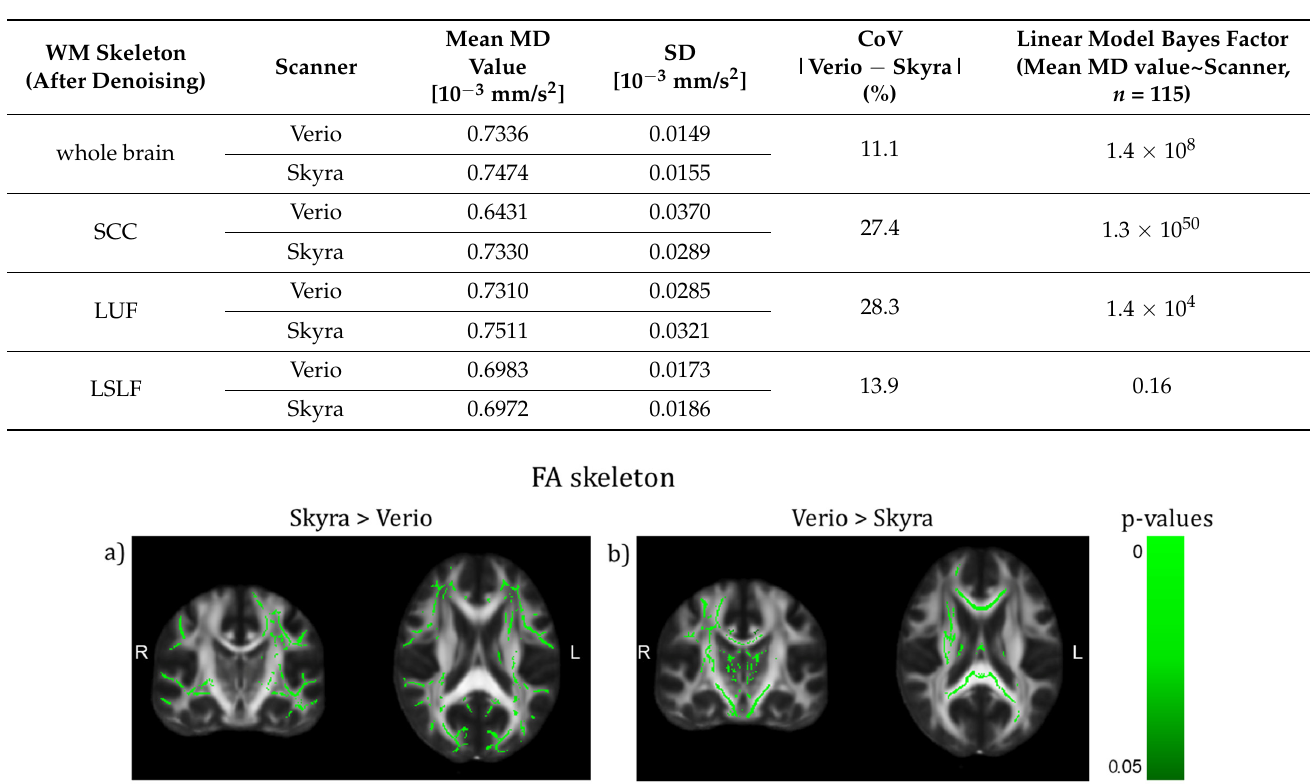
Table 2. Mean MD values of the white matter skeleton at the whole-brain level and in different ROIs (CMRR sequence, after denoising). Bayesian linear modelling shows significant scanner differences on the whole brain level and for central and lateral ROIs (SCC and LUF) but scanner differences in the LSLF are not evident.